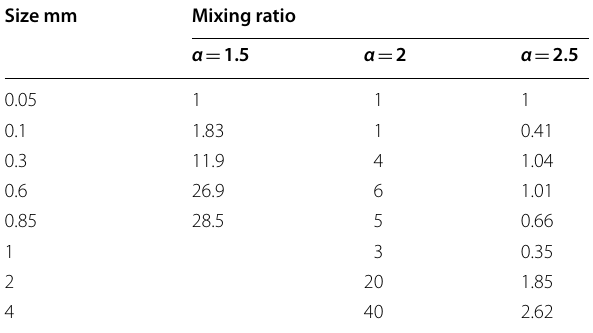
The ratio is represented as the total mass of glass beads for each size normalized by the total mass of 50 μm beads. The value of α is the power-law exponent of the cumulative number of target constituent glass beads